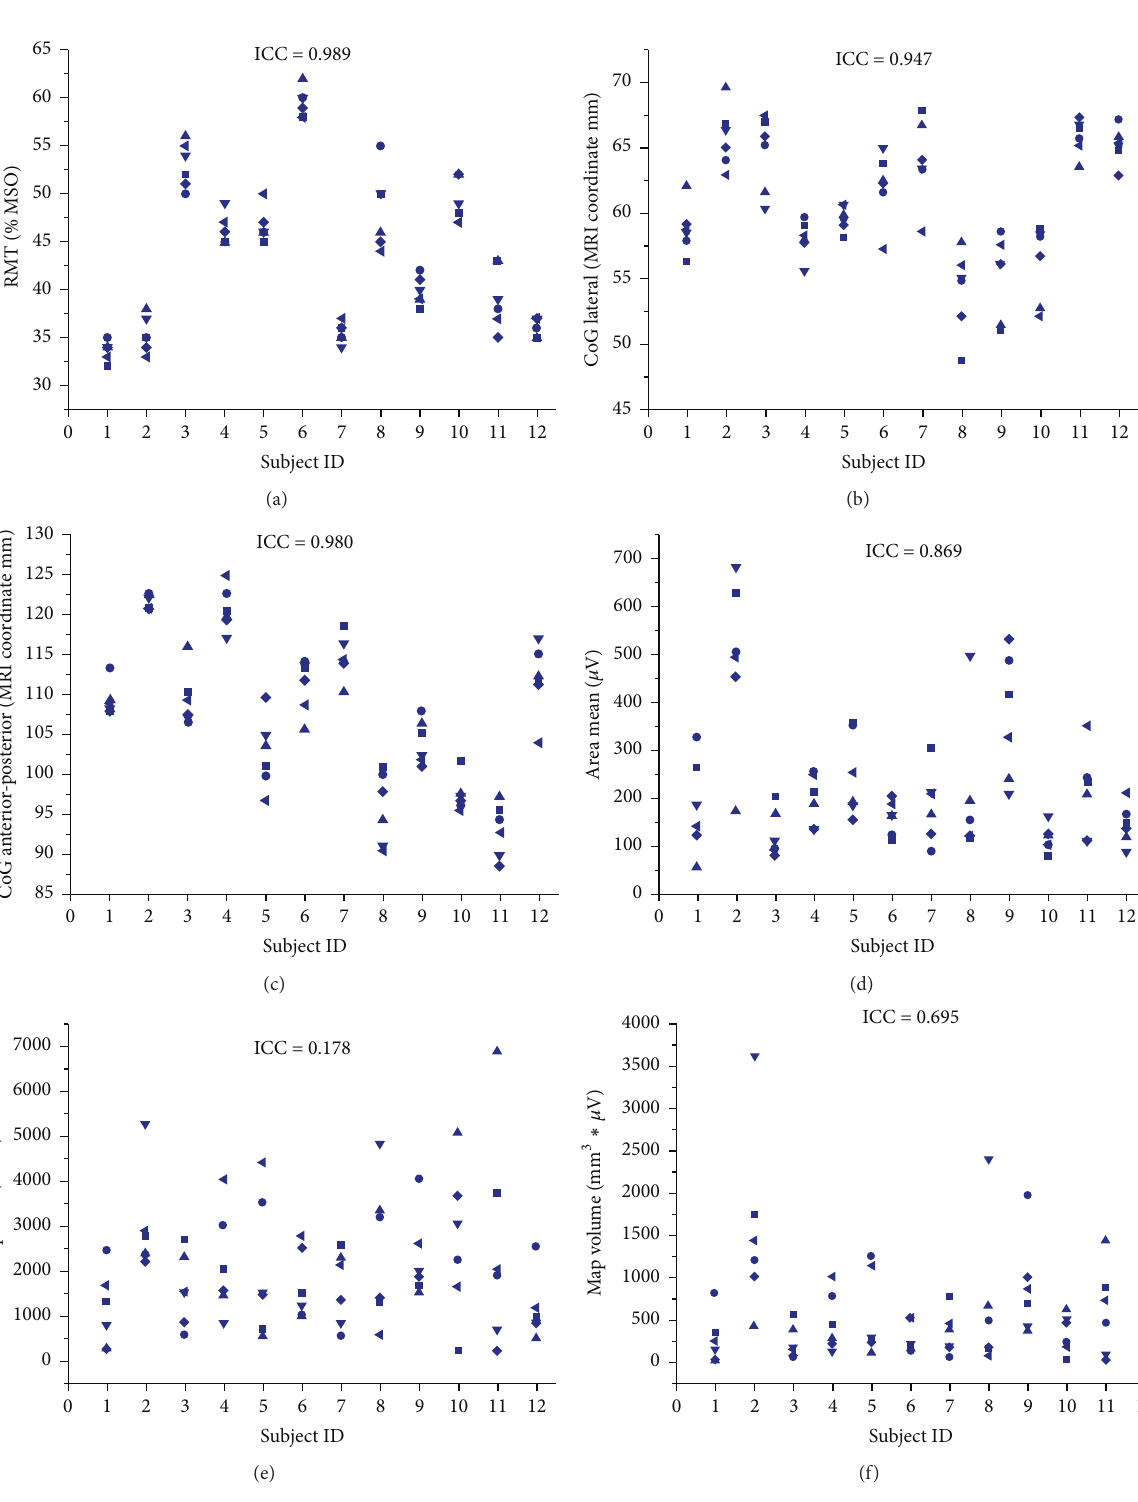
Figure 1: Intrasubject distribution of original data for six experimental sessions ( ◼ : Session 1; e : Session 2; 󳵳 : Session 3; 󳶃 : Session 4; X : Session 5; 󳶣 : Session 6) in the right, nondominant hemisphere of twelve subjects for RMT (a), medial-lateral CoG (b), anterior-posterior CoG (c), mean map MEP amplitude (d), map area (e), and map volume